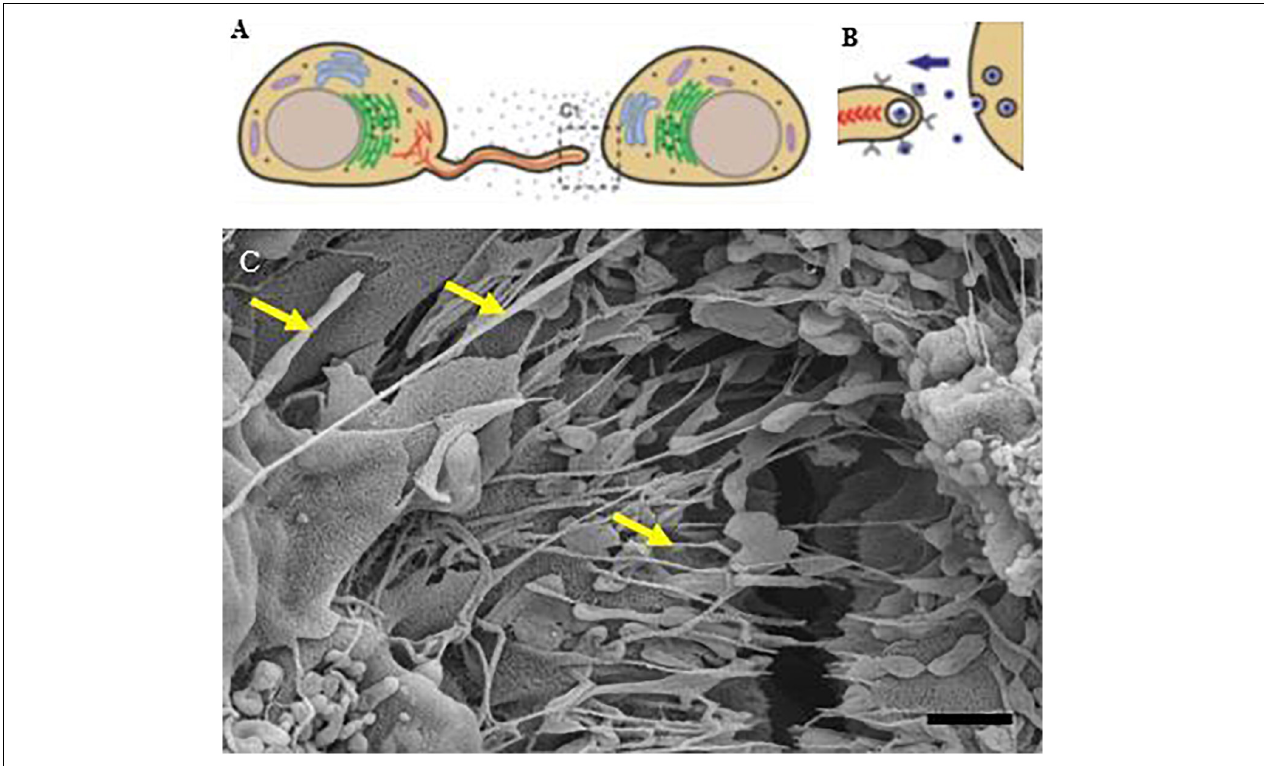
FIGURE 12 | An illustration of basolateral NT progression from membranous filopodia into “closed-ended” structures (A,B) (Fulga and Rørth, 2002; Gurke et al., 2008). (C) Depicts, morphologically, the formation of TUNTs and TENTs grown on a Millicell substrate and displaying apicolateral projecting nanotubes as seen by the “yellow arrows.” Scale bar = 1,000